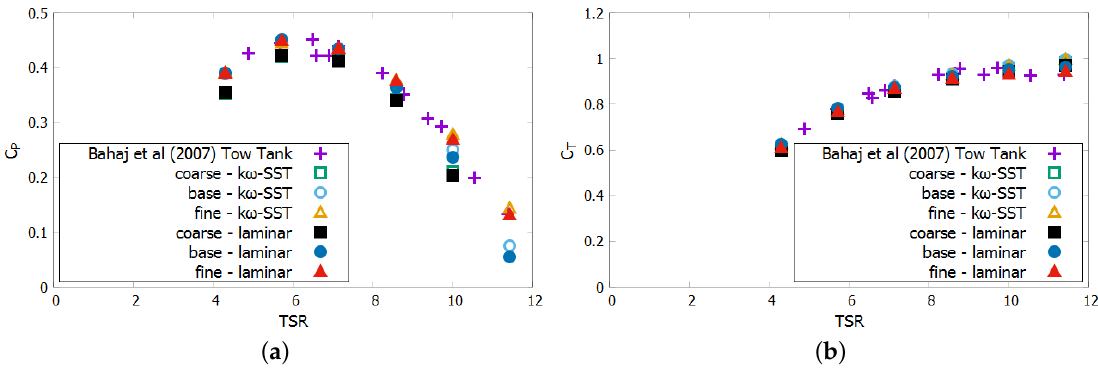
Figure 4. Freestream C P and C T as a function of TSR. ( a ) C P ; ( b ) C T .